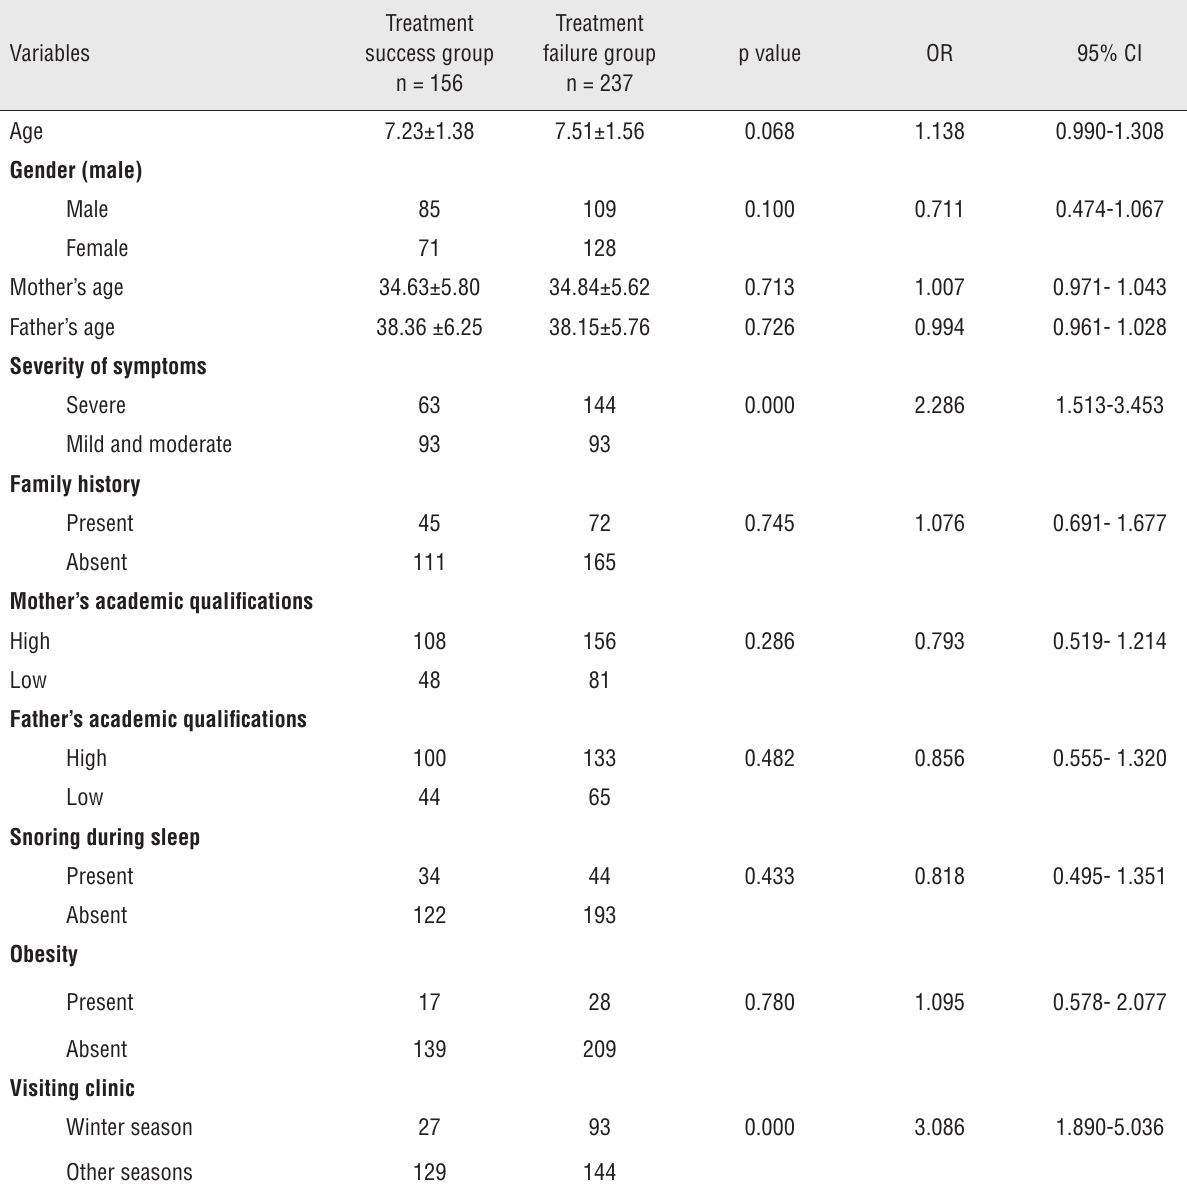
Table 2 - Univariate logistic regression analysis was performed to assess risk factors for desmopressin treatment failure. (n = 393). Variables